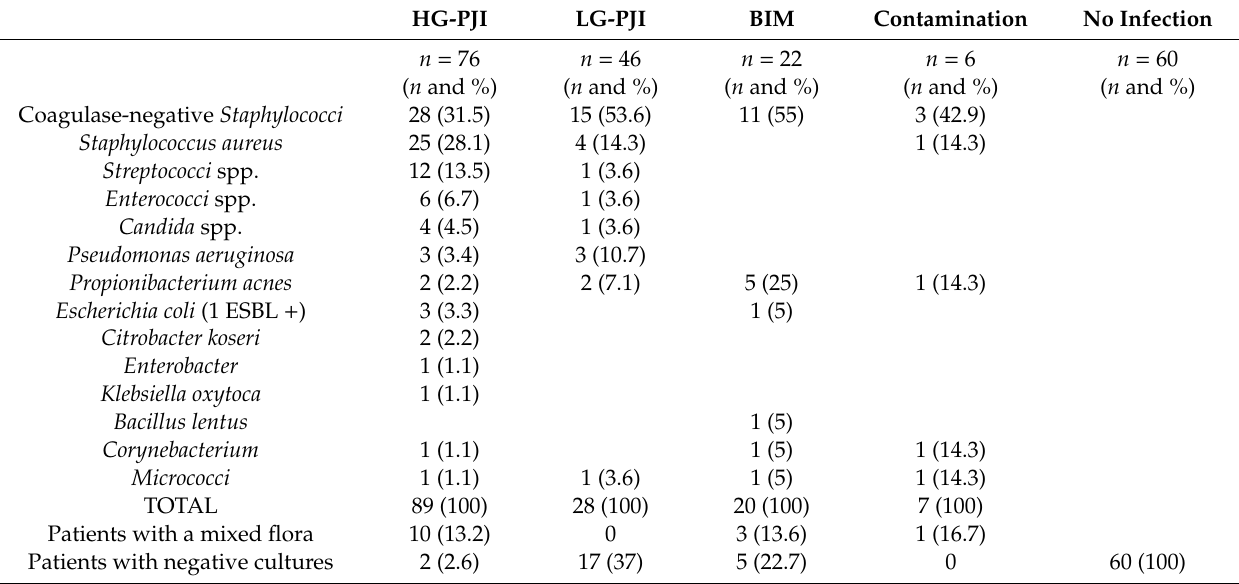
Table 8. Post-operative results of cultural